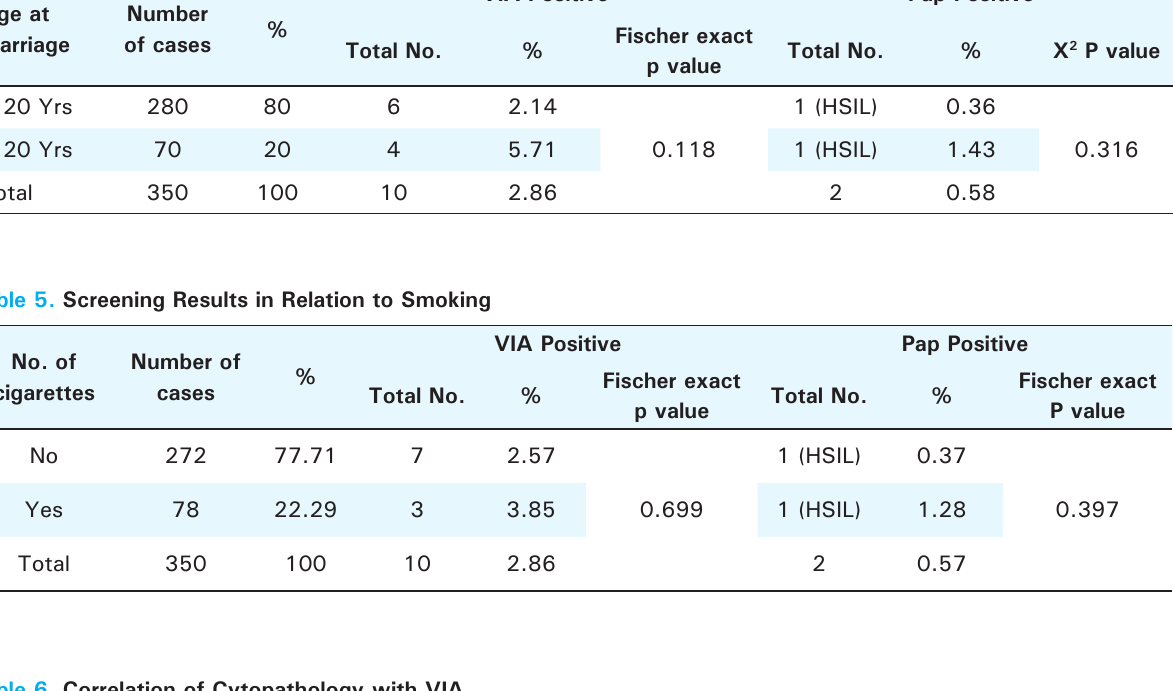
table 6. correlation of cytopathology with VIA Pap report number of cases %